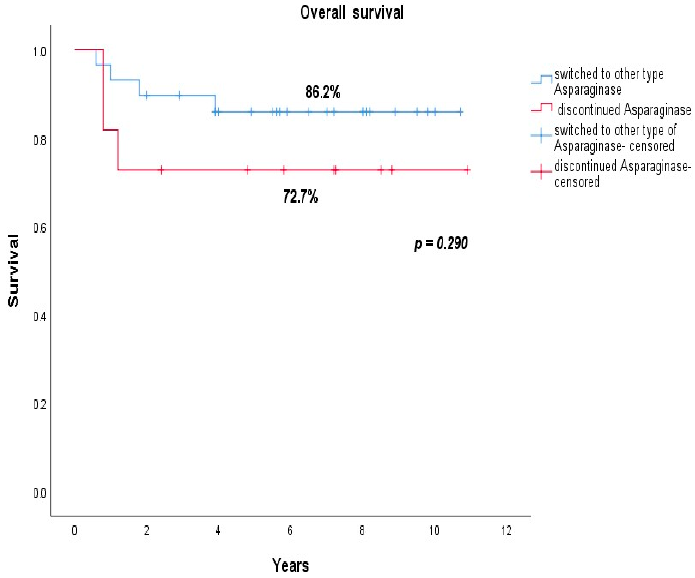
Figure 1. Overall survival of patients who switched to another type of asparaginase (blue line) vs. patients who discontinued asparaginase (red line).